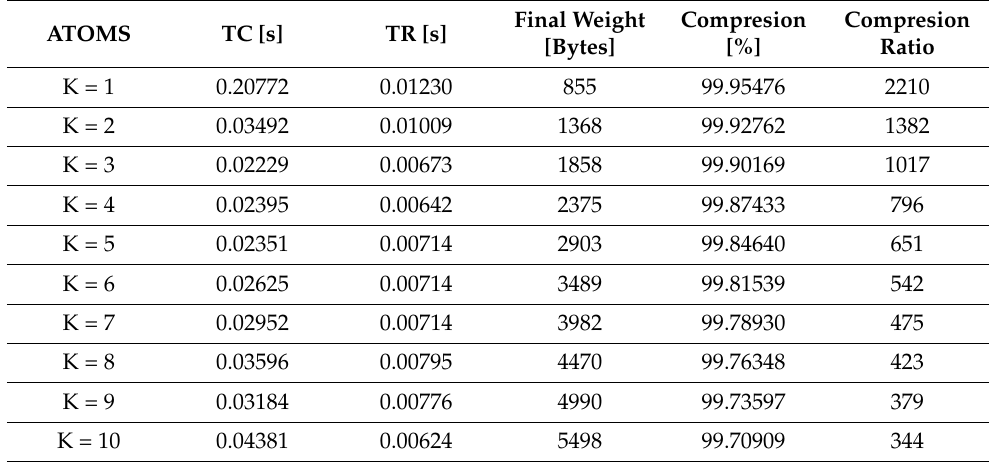
Table 1. Results summary.